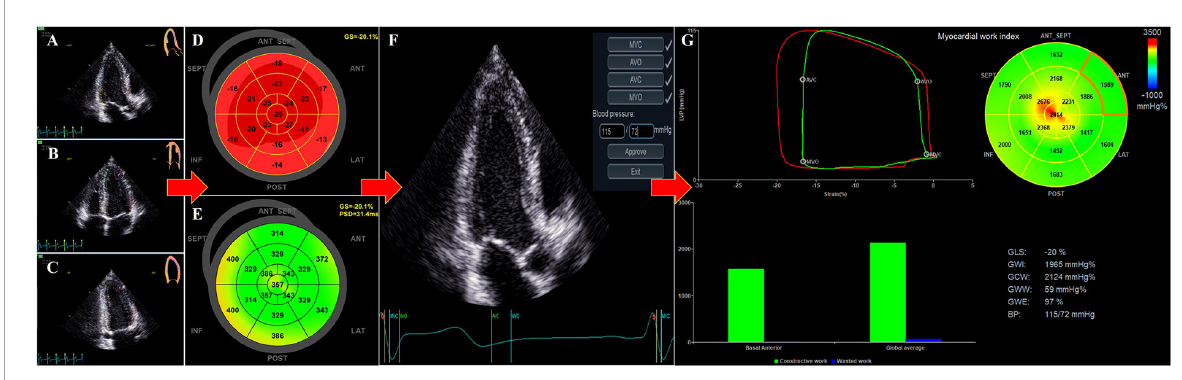
FIGURE1 Non-invasive determination of left ventricular (LV) myocardial work from echocardiography. Using automated function imaging (AFI) software, images of the apical long–axis (A) , apical four– (B) and two–chamber (C) views were analyzed to determine LV global longitudinal strain (GLS) (D) and peak strain dispersion (PSD) (E) . After adjusting the event timing of aortic and mitral valve closure and opening in the apical long-axis view and inputting the blood pressure (BP) value (F) , the Bull’s-eye images of 17 LV segments for myocardial work index or myocardial work efficiency were presented with global myocardial work values (G) , including global work index (GWI), global constructive work (GCW), global wasted work (GWW), and global work efficiency